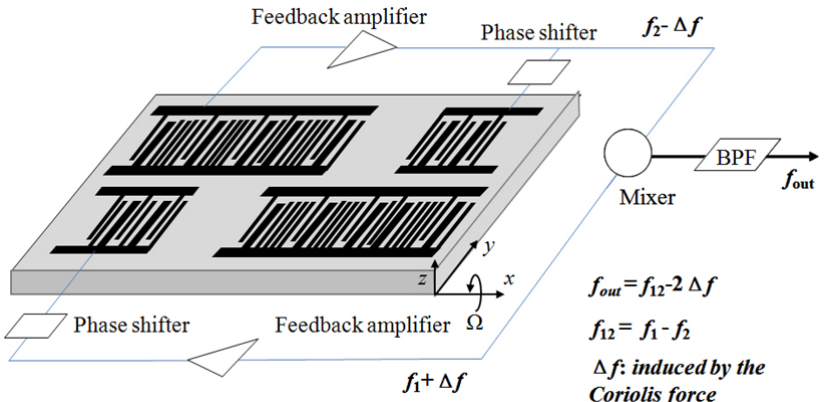
Figure 1. The schematic of the present SAW